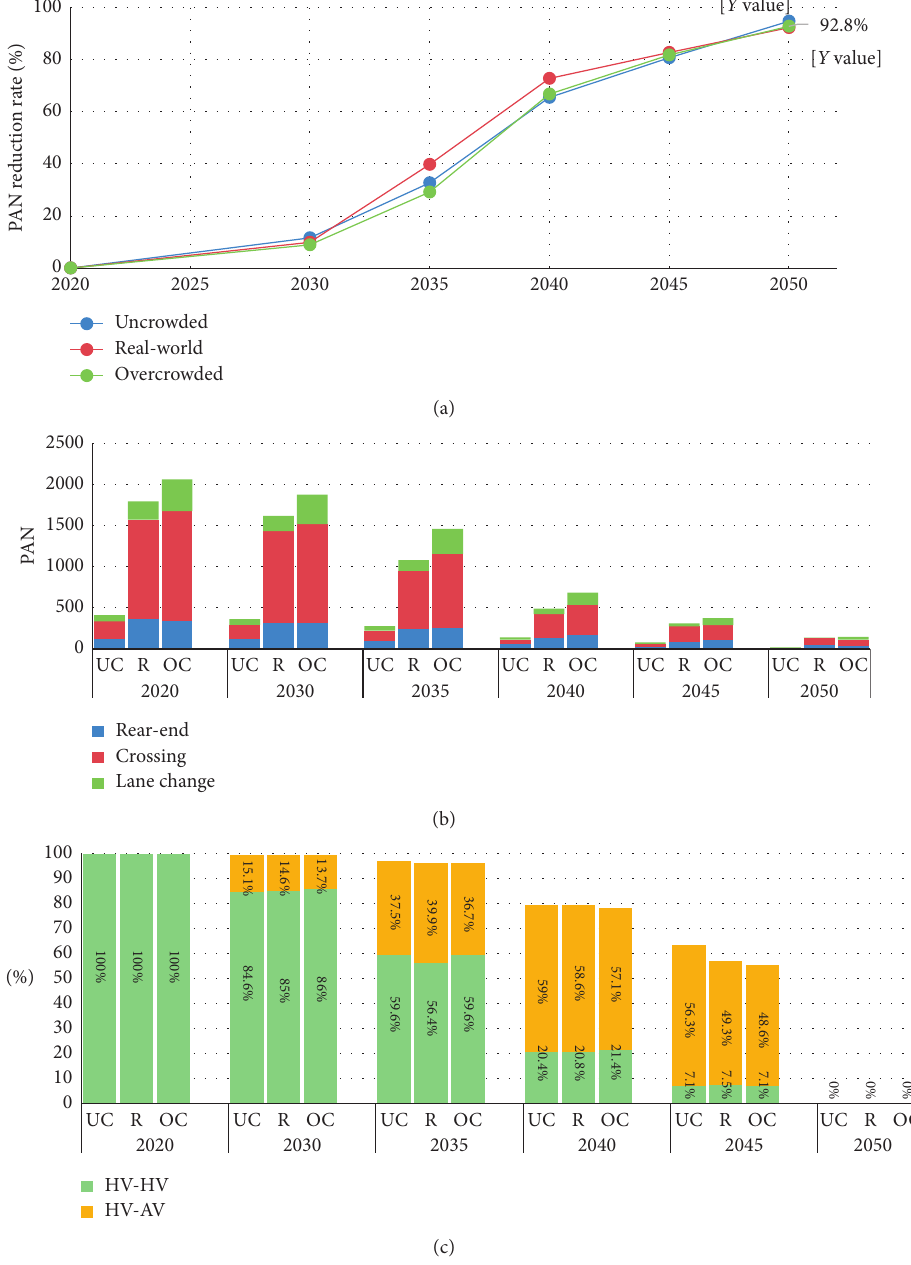
Figure 9: Detailed results of PAN at Sattarkhan intersection for each demand scenario (UC: uncrowded, R: real-world, OC: overcrowded). (a) Potential accident number reduction rate. (b) PAN segregated by conflict type. (c) Percentage of PAN involving